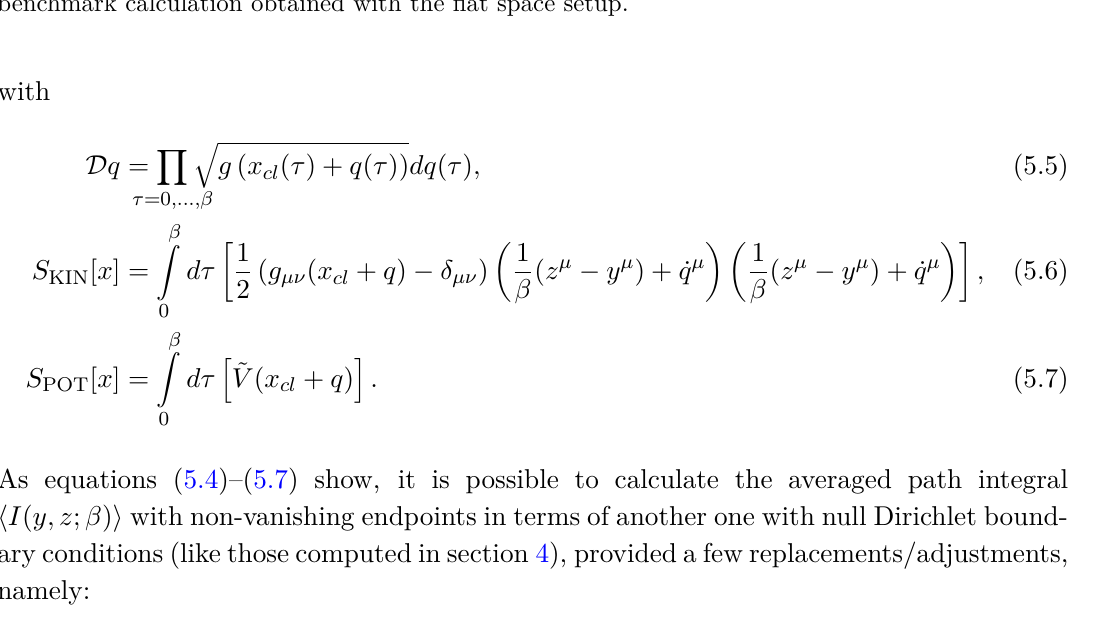
Figure 7 . Calculations of the heat kernel for the free scalar particle propagating from y = (0 , 0 , 0 , 0) to z = (5 , 5 , 5 , 5) on a hyperboloid with D = 4 and | M | = 1 . The blue points show a calculation performed with the non-linear sigma model method, whereas the green points are referred to a benchmark calculation obtained with the flat space